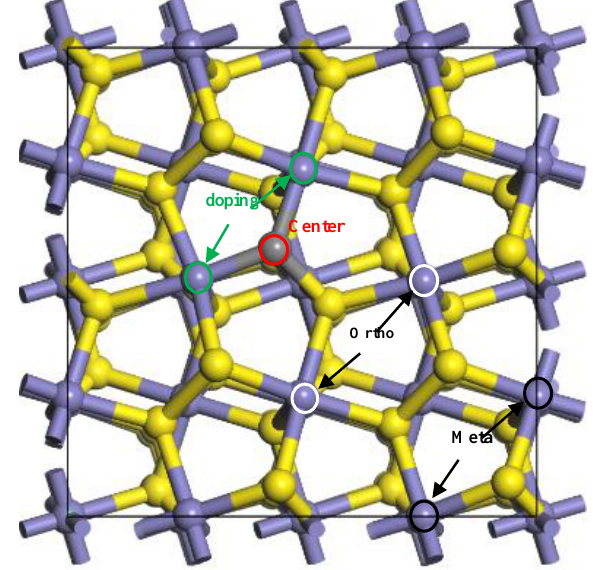
ff erent adsorption sites of H Figure 2. The different adsorption sites of H 2 O on the coal pyrite surface. Figure 2. The di